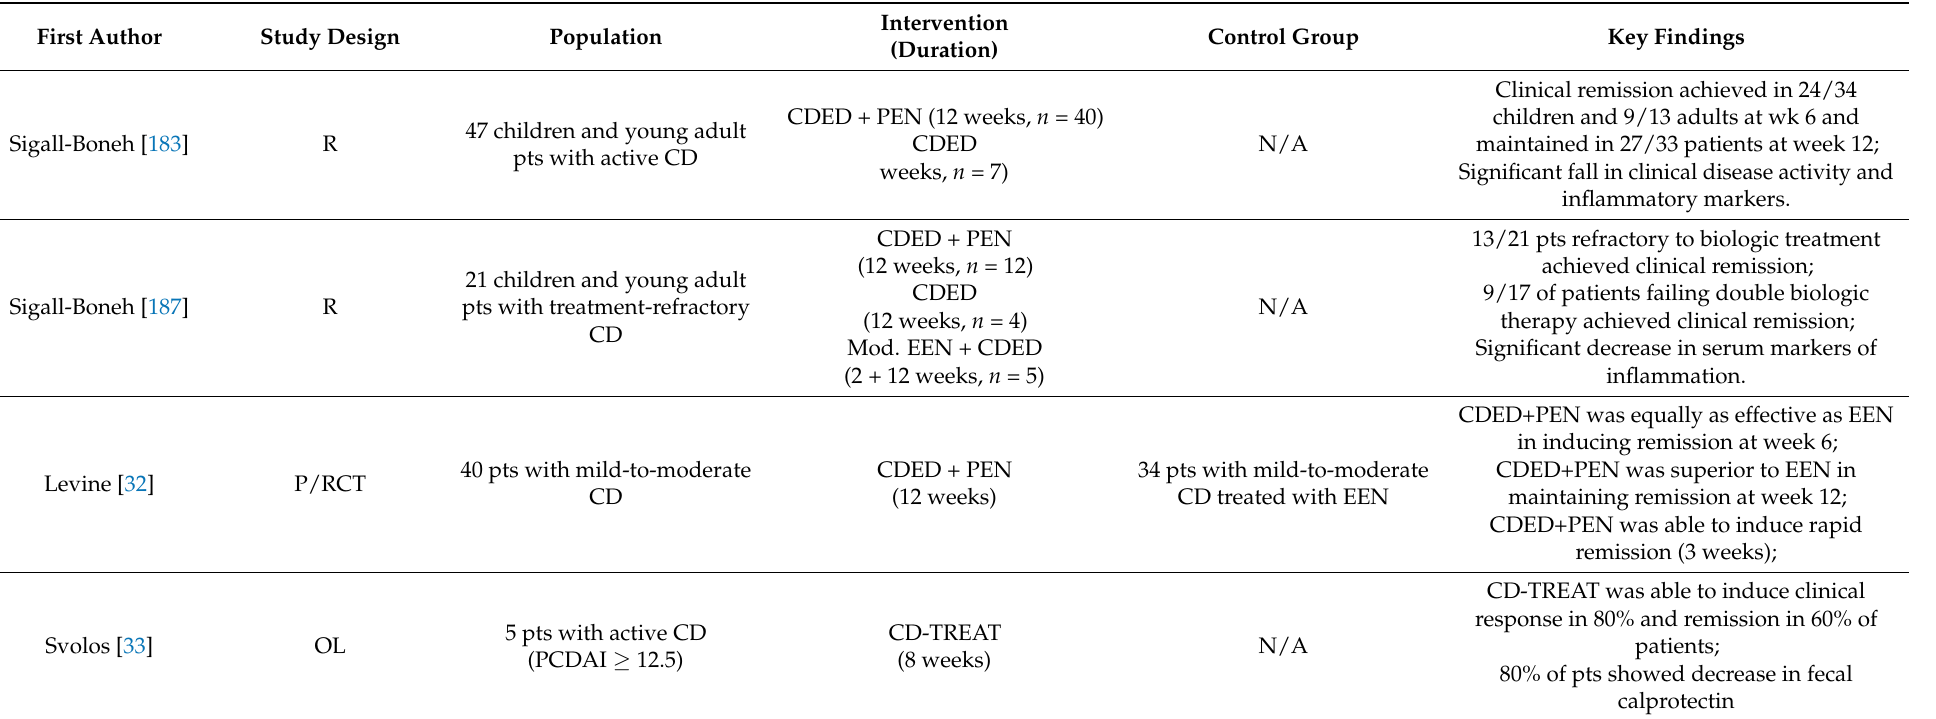
Table 2. Summary of the studies using food-based therapies in children with